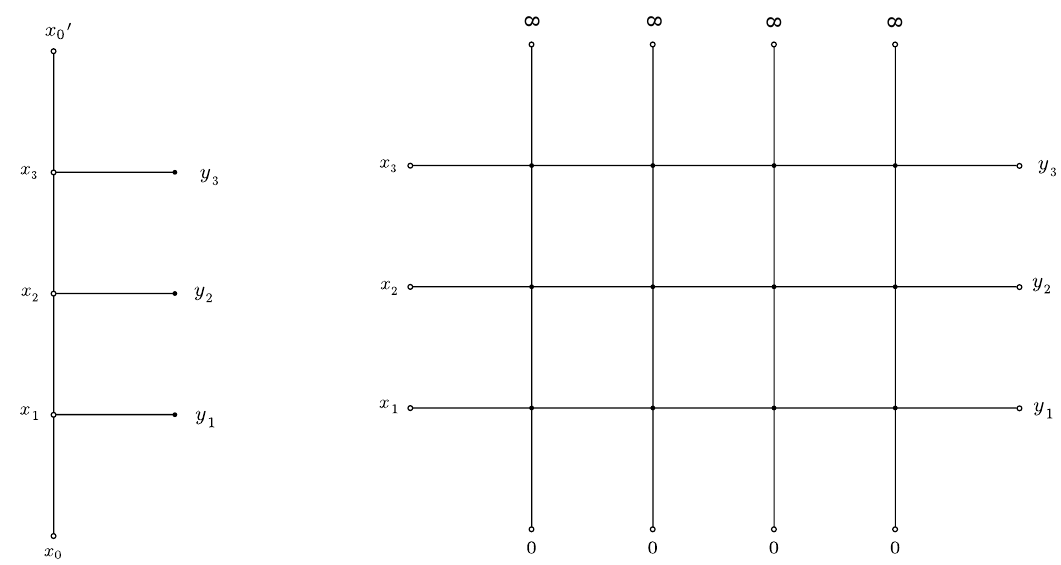
= ∞ (amputation of upper legs), 0